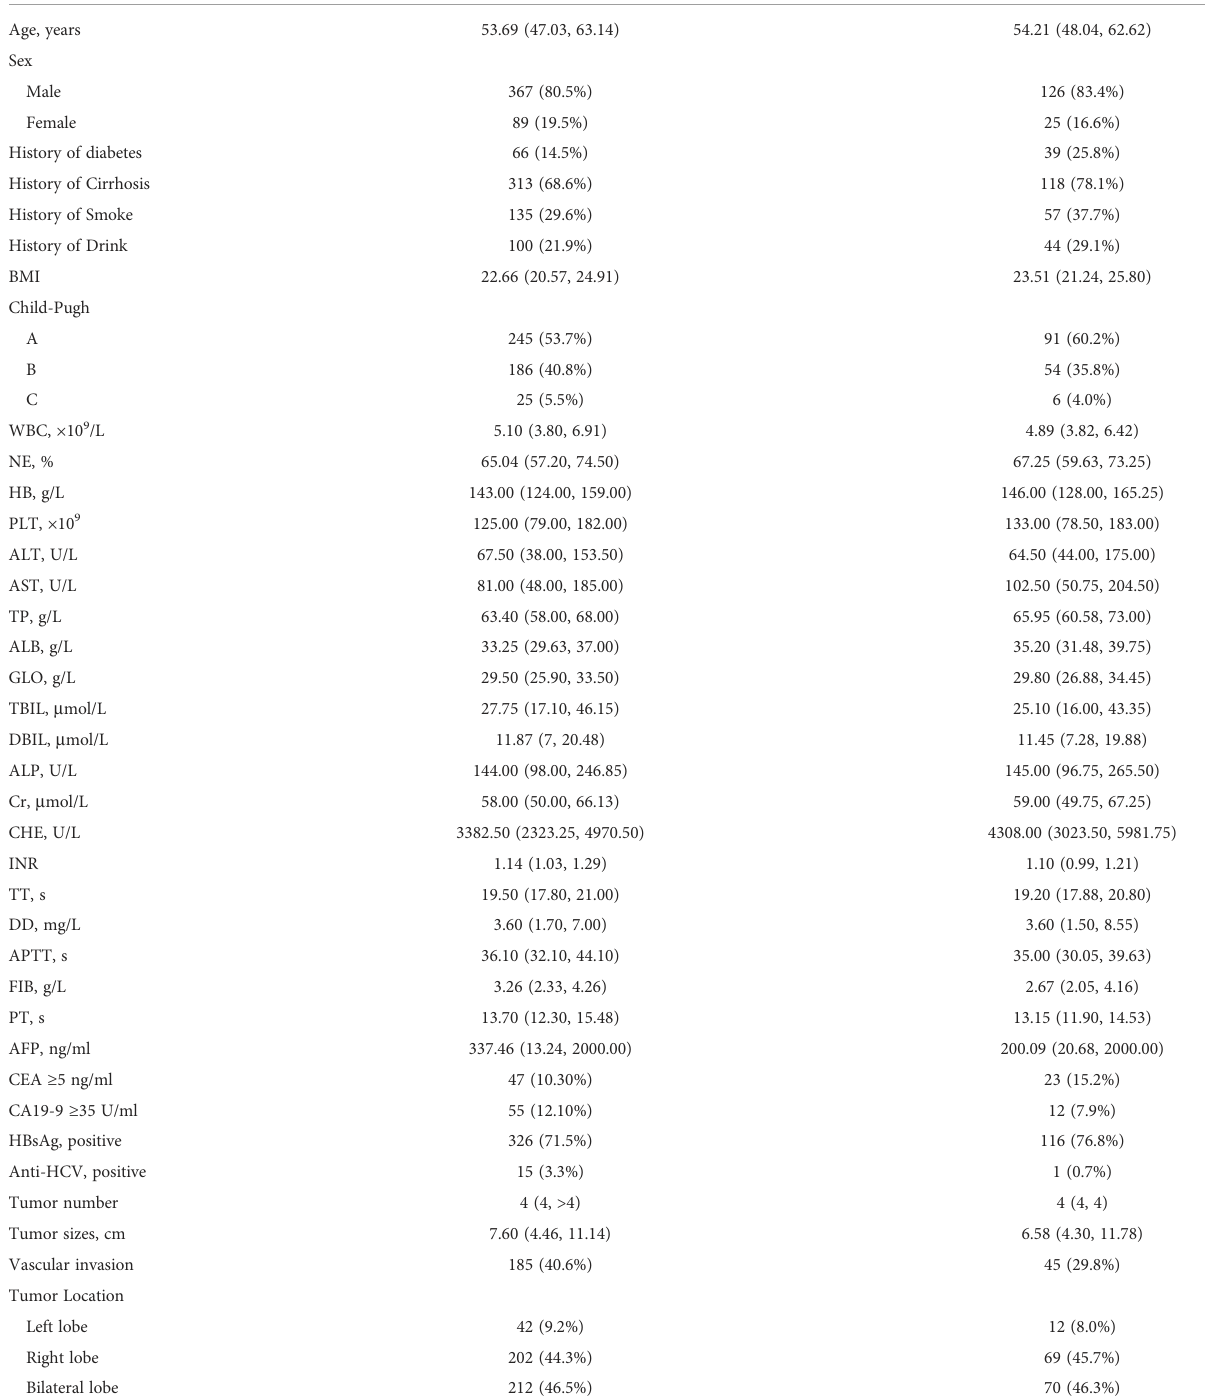
TABLE 1 Baseline clinical characteristics of inital